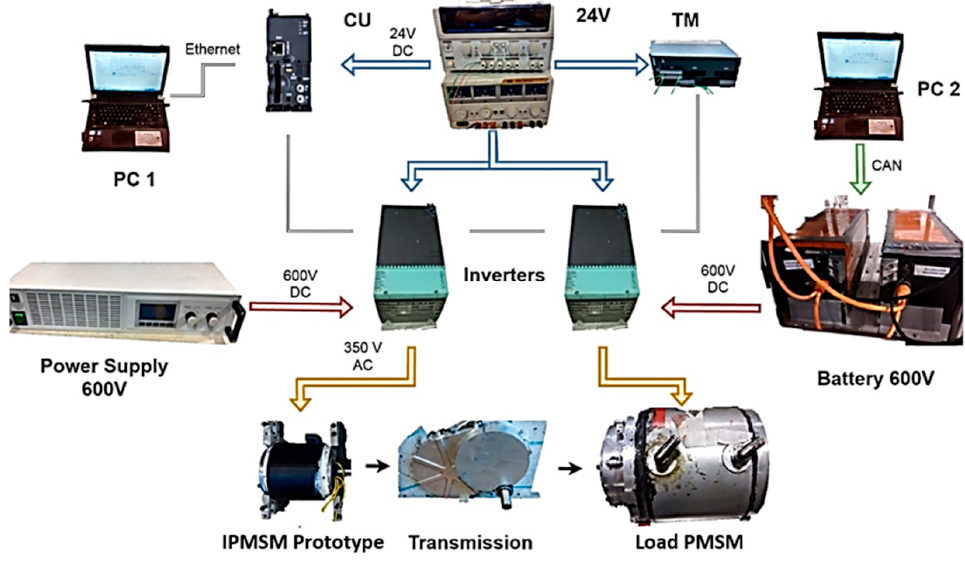
Figure 20. Overall diagram of the working testbench.